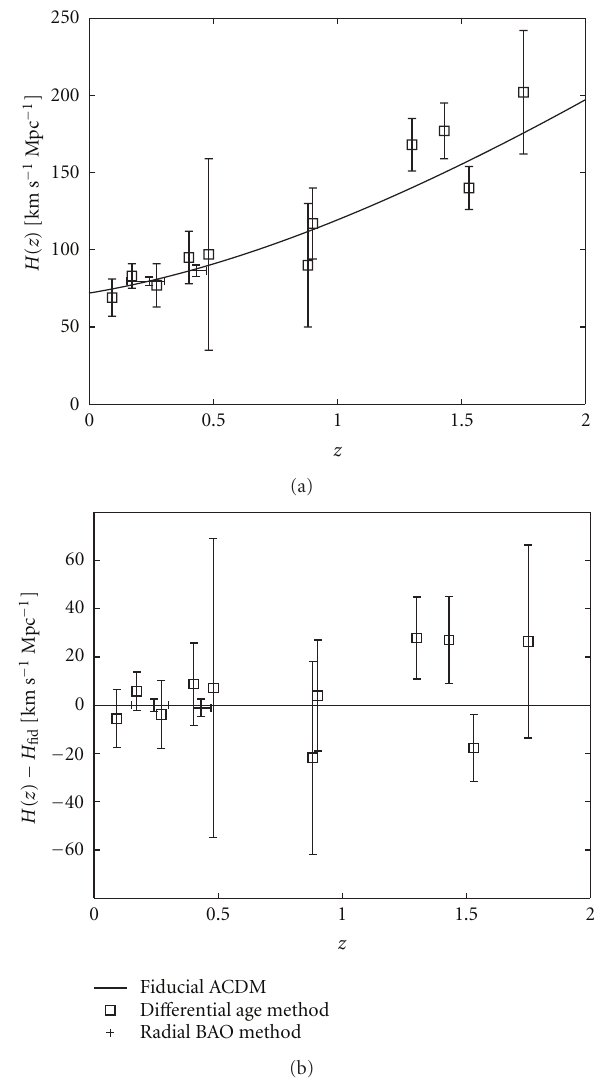
Figure 4: (a) the available H ( z ) data from both di ff erential age method and radial BAO size method (see Table 1 and references therein). The solid curve plots the theoretical Hubble parameter H fid as a function of z from the spatially flat Λ CDM model with Ω = 0 . 25, Ω Λ = 0 . 75,and H = 72kms − 1 Mpc − 1 . (b) the same m 0 data, but the residuals with respect to the theoretical model H fid are plotted. In both panels, the z error bars on the measurements from the radial BAO method are used to mark the extents of the two independent redshift slices in which the BAO peaks were